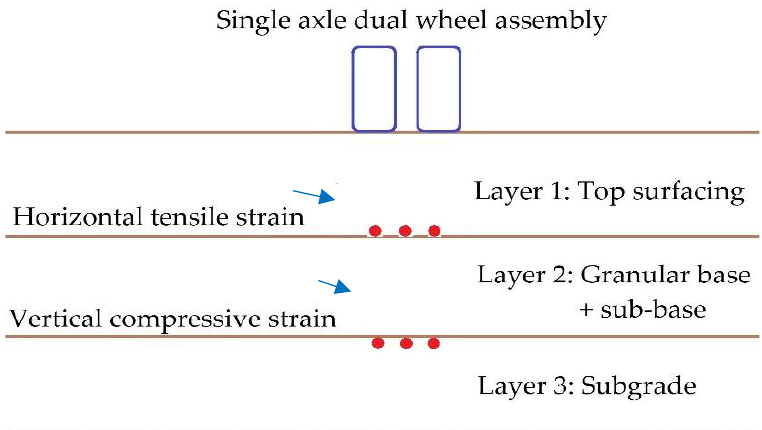
Figure 3. Location of critical strains.